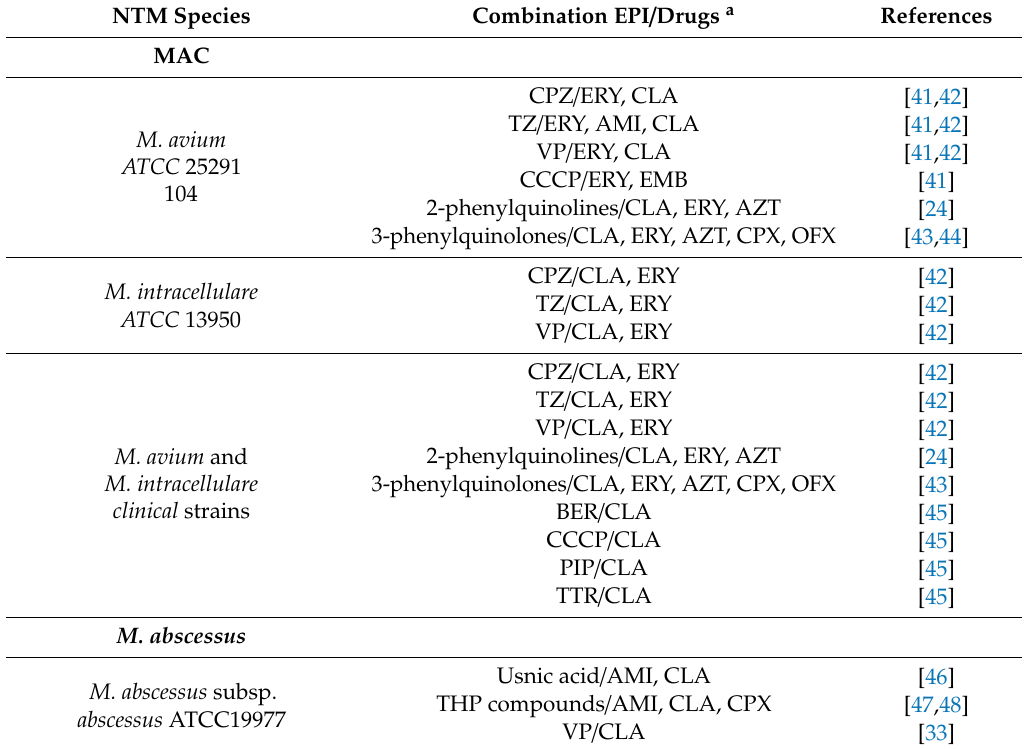
Table 2. Combinations of e ffl ux pumps inhibitors (EPIs) and drugs evaluated in NTM species, where EPIs decreased the minimal inhibitory concentrations (MICs) of the